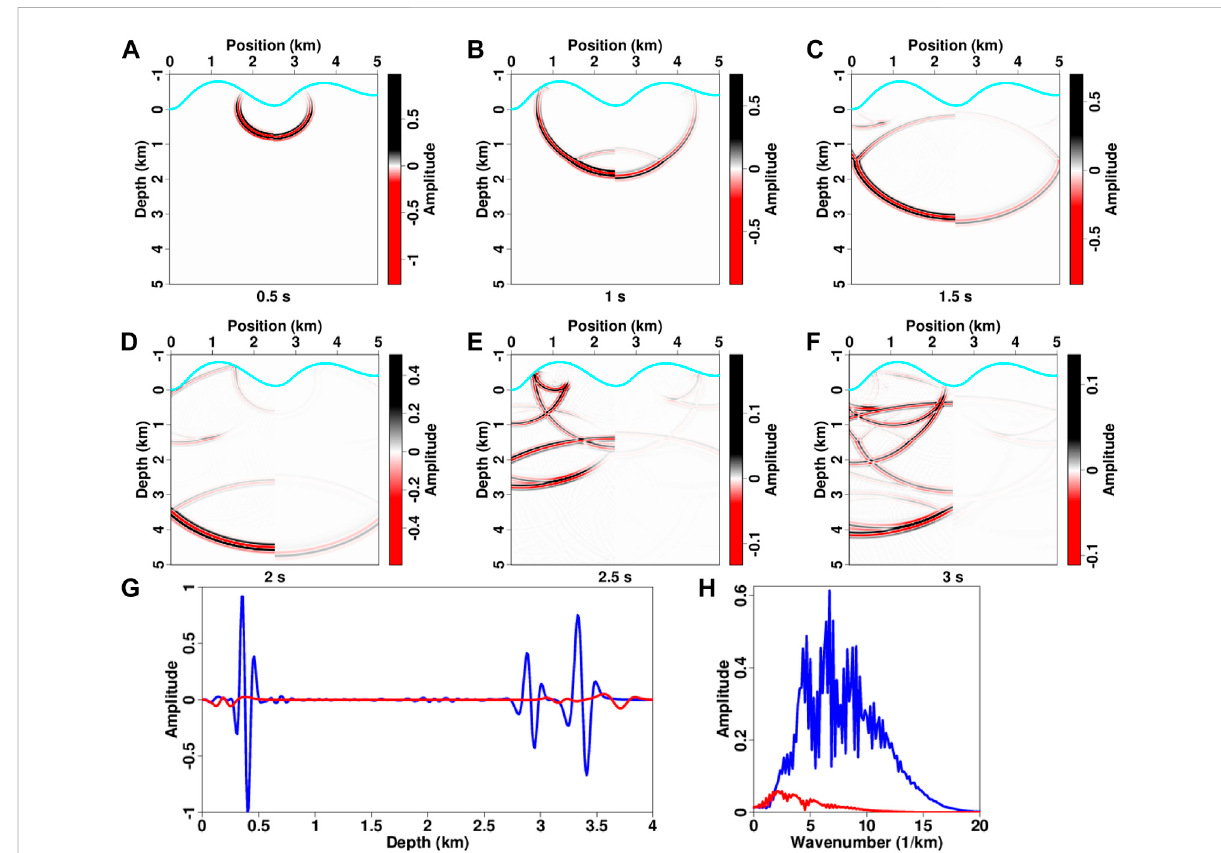
FIGURE 7 (A – F) Comparisons of acoustic (left half panel) and viscoacoustic (right half panel) wave fi elds at different propagation times. A free surface is used as the boundary condition on the topography. (G) Single-trace comparison at x = 3 km, and (H) corresponding spectra comparison, in which blue lines denotes acoustic results and red lines denote viscoacoustic results. The cyan lines in (A – F) denote the